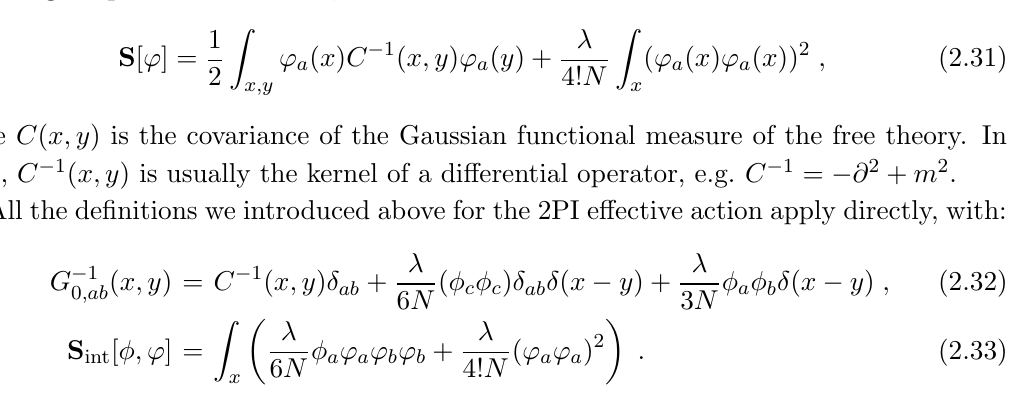
Figure 1 . The two vertices from eq.